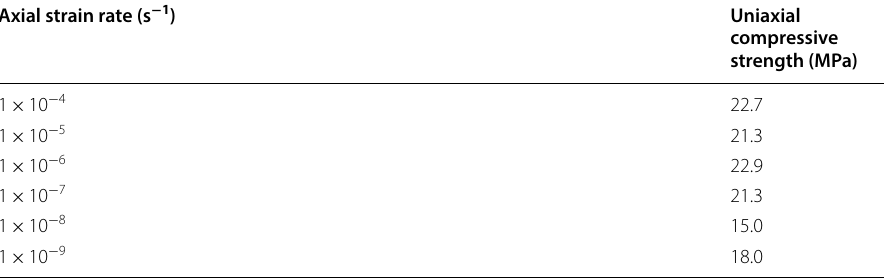
Table 7 Summary of the uniaxial compressive strength experiments performed on Rothbach sandstone at different strain rates Axial strain rate (s − 1